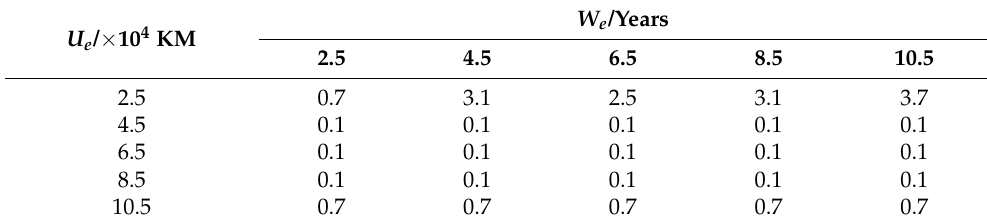
Table 6. The optimal 2D EW scheme (unit: years).